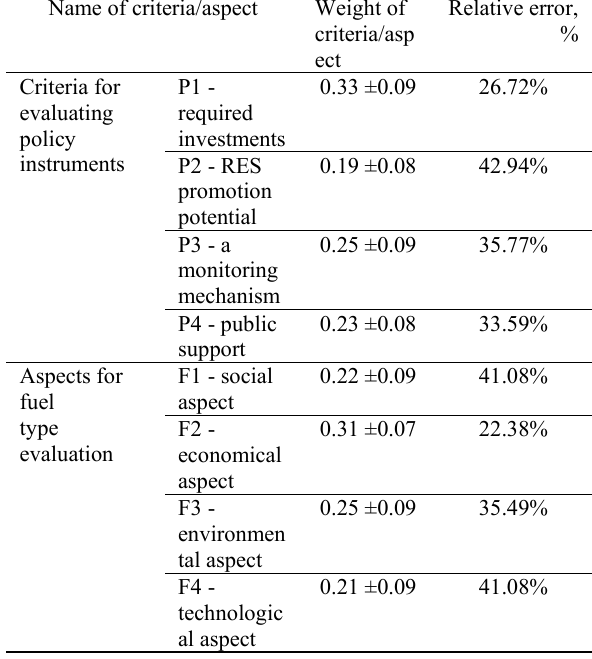
Table 3. Relative error of determined weights of evaluation criteria/aspects.